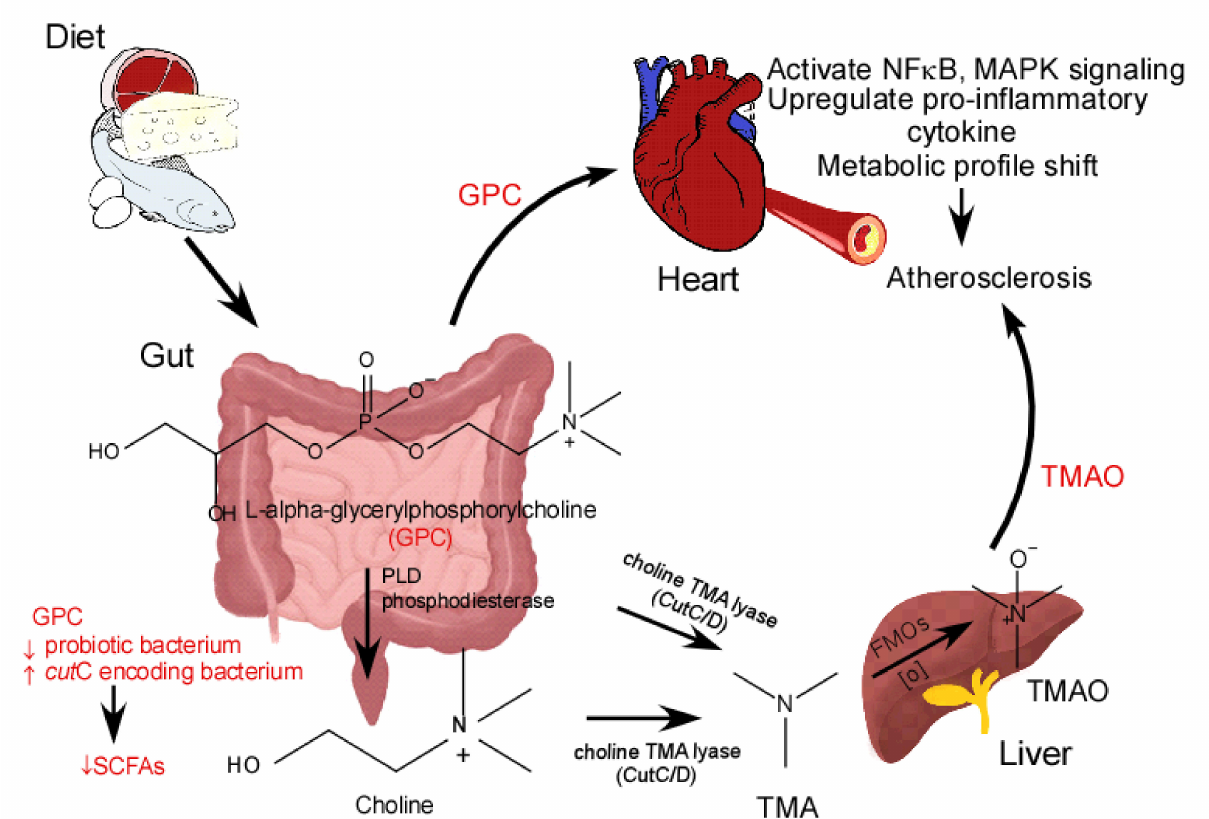
Figure 14. Schematic Figure showing GPC promoting atherosclerosis through multiple mechanisms. PLD, phospholipase D; FMOs, Flavin monooxygenases; SCFAs, short chain fatty